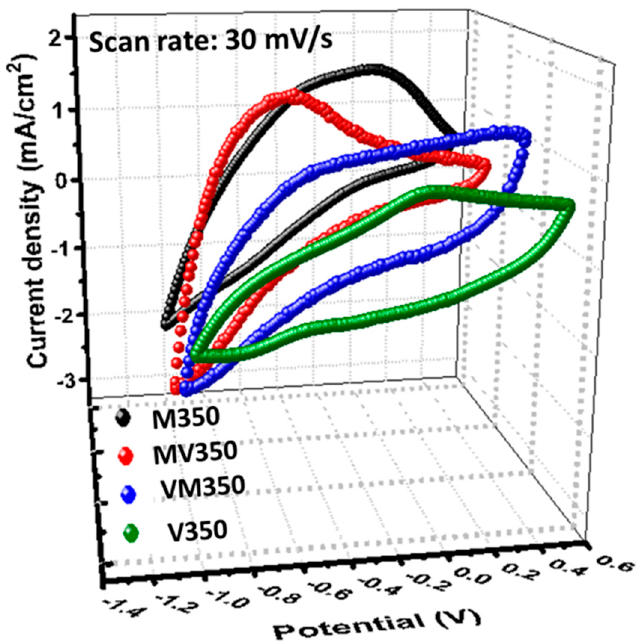
◦ C for 2 h in air. / V 2 O 5 hybrid nanobilayers heated at 350